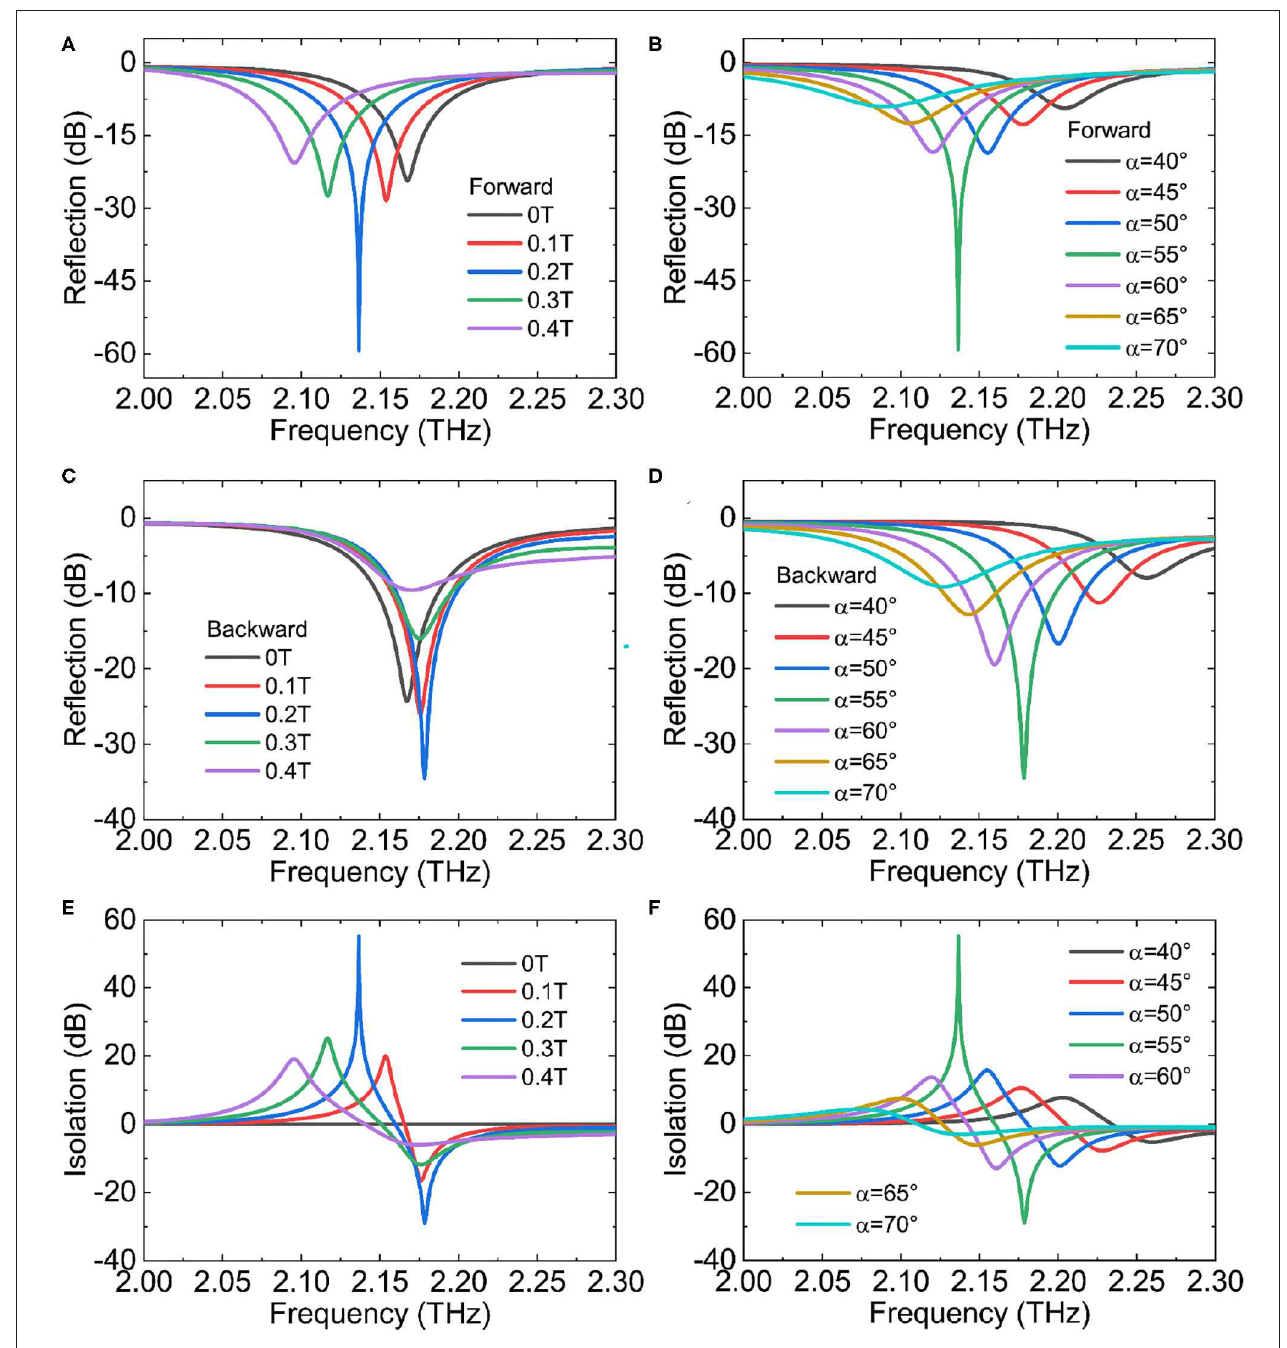
FIGURE 4 | (A) Reflection spectra of the forward waves, (C) reflection spectra of the backward waves and (E) isolation spectra under the different external magnetic fields when α 55 ◦ at room temperature. (B) Reflection spectra of the forward waves, (D) reflection spectra of the backward waves and (F) isolation spectra under = the different incident angles when B =